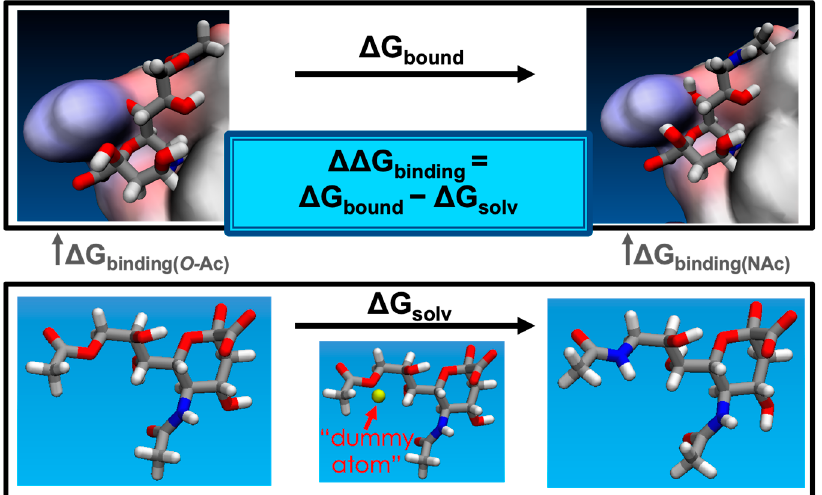
Figure 6. Visual representation of ΔΔ G binding of Neu5Ac9NAc versus Neu5,9Ac 2 in the SARS-CoV-2 S protein, where ΔΔ G binding is the difference of two alchemical transformations in explicit solvent (boxed). The upper box is the transformation from Neu5,9Ac 2 to Neu5Ac9NAc bound in the protein and solvated in explicit water. The lower box is the transformation in explicit water. Additional atoms required in transformations are represented by “dummy atoms” whose interactions are gradually turned on as one progresses over the alchemical intermediates.